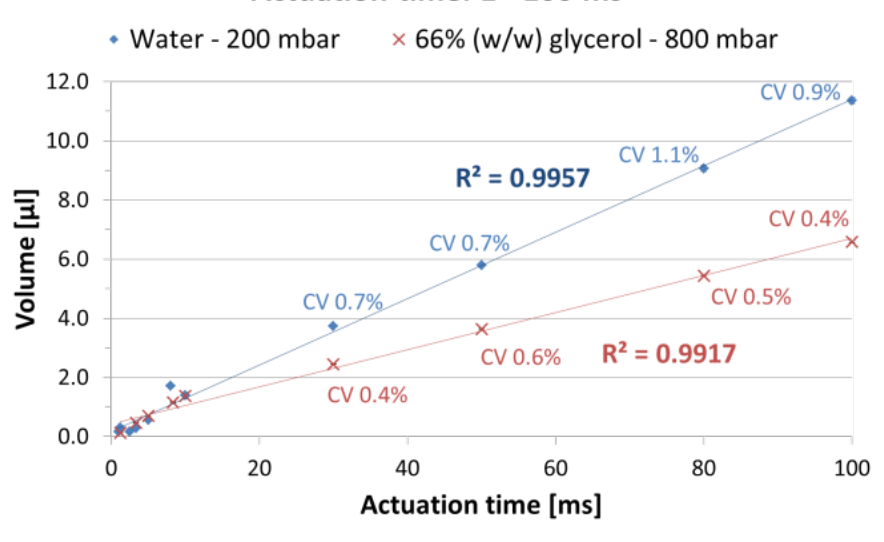
Figure 7. The dispensed volume in dependence of the actuation time for water (blue squares) and glycerol (red crosses). Each data point represents one run of 24 individually measured aliquots. Percentages and corresponding error bars (too small to be visible in this figure) state the respective Intra-Run CV .